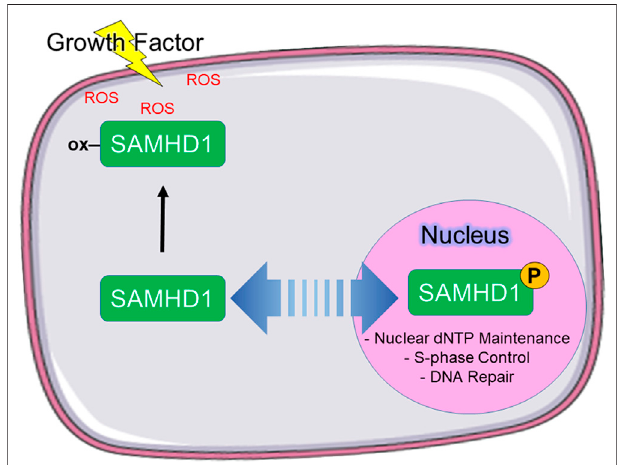
FIGURE 5 | Proposed model of SAMHD1 localization and cellular function. We propose that phosphorylation directs subcellular localization, which in turn directs cellular function. In our model, phosphorylated SAMHD1 is retained in the nucleus where it is able to participate in nuclear functions. Unphosphorylated SAMHD1 can be stimulated to leave the nucleus, where it can be oxidized in response to growth factor- stimulated